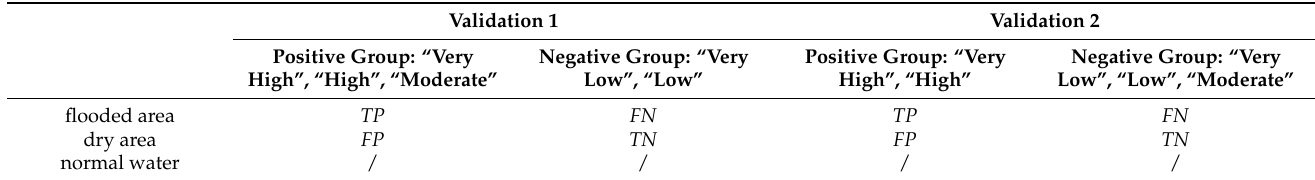
Table 5. The classes and rating of factors in flood hazard